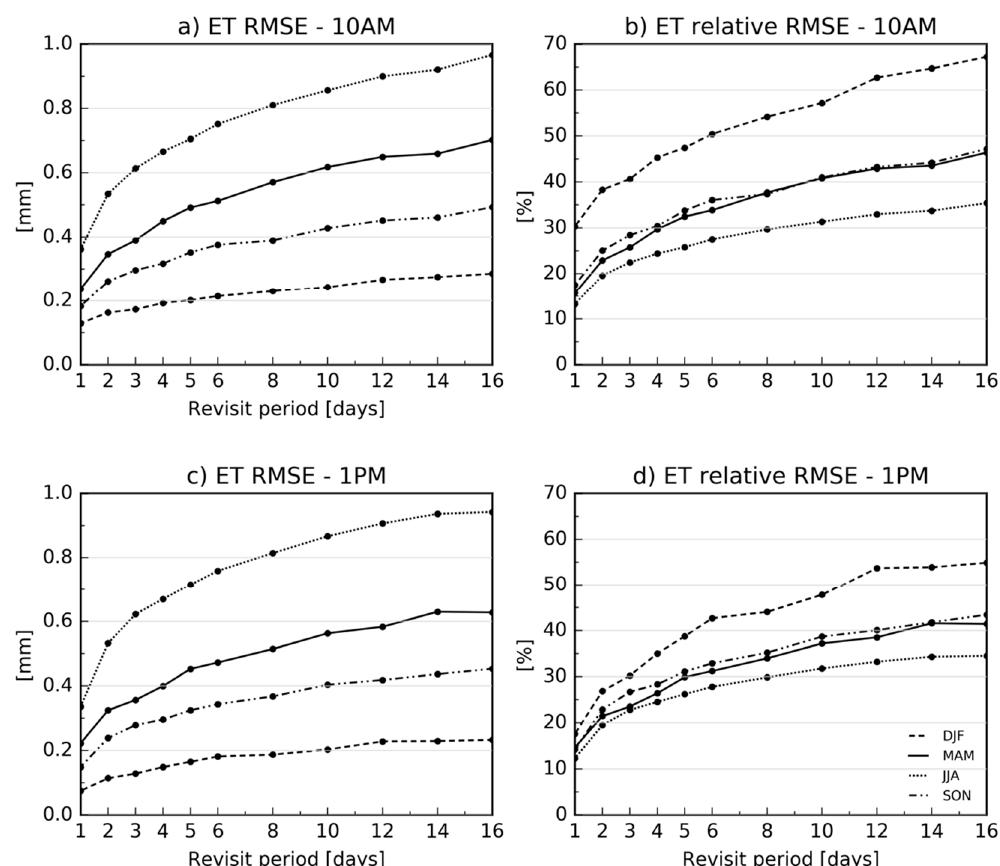
Figure 7. Absolute ( a , c ) and relative ( b , d ) root Mean Square difference (RMSE) between ET measured by the AmeriFlux sites (integration of all daytime measurements for all sky conditions) and derived from the different revisit scenarios for a 10:00 ( a ) and 13:00 ( b ) simulated satellite overpass time using daytime scaling and interpolation process for cloudy days. The relative difference represents the ratio between the RMSE and the measured seasonal mean ET.